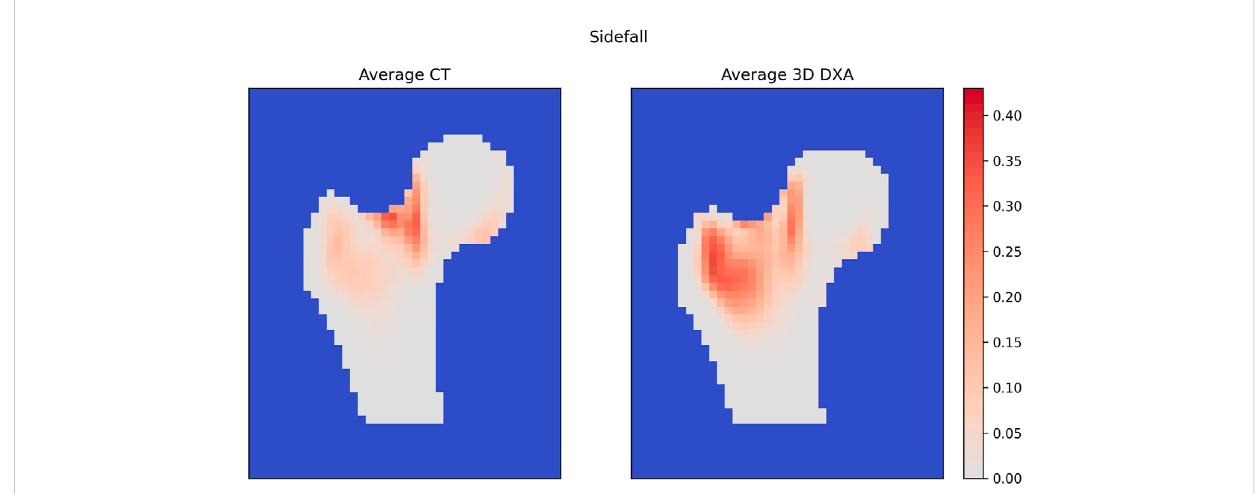
FIGURE 9 Average damage maps for QCT and 3D DXA mapped on the standard